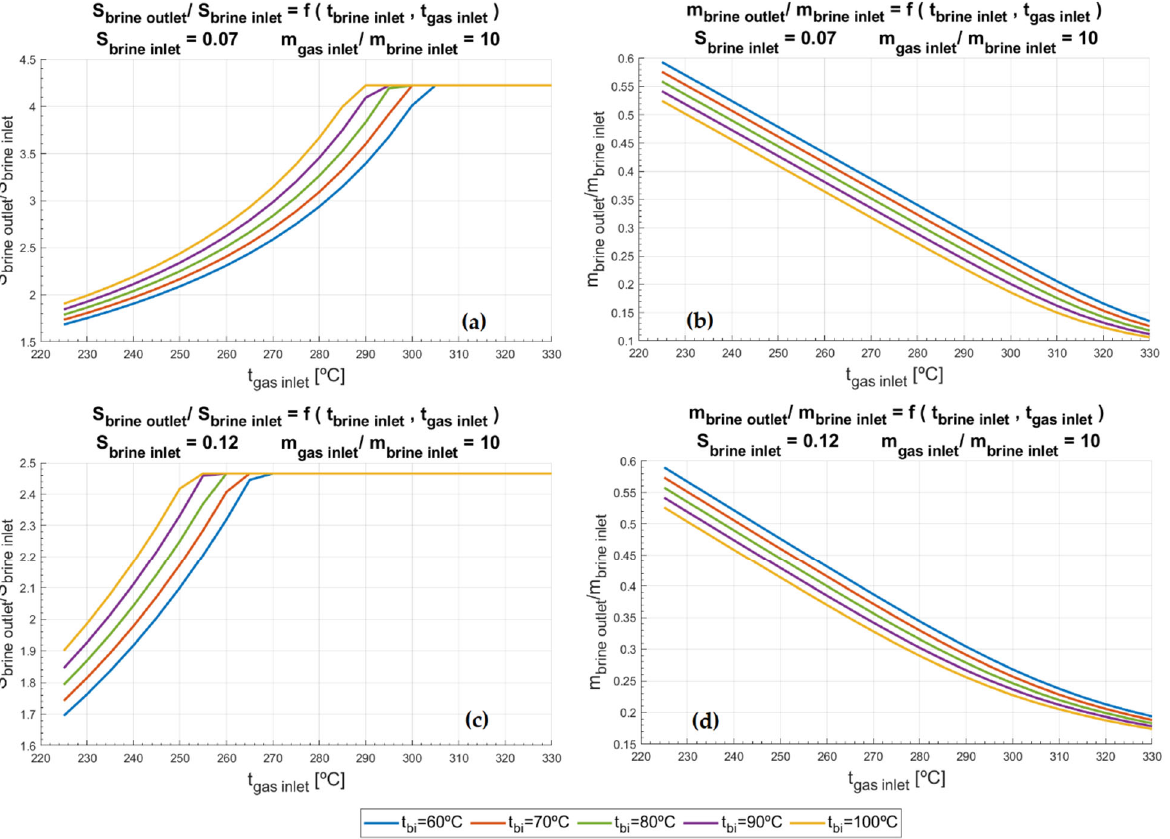
Figure 6. ( a ) Ratio between outlet and inlet brine salinities as a function of temperatures of inlet brine and inlet exhaust gases from the turbine in evaporation chamber, for S bi = 0.07 kg/kg and m g /m b = 10; ( b ) Ratio between outlet and inlet brine mass flow rates as a function of temperatures of inlet brine and inlet exhaust gases from the turbine in evaporation chamber, for S bi = 0.07 kg/kg and m g /m b = 10; ( c ) Ratio between outlet and inlet brine salinities as a function of temperatures of inlet brine and inlet exhaust gases from the turbine in evaporation chamber, for S bi = 0.12 kg/kg and m g /m b = 10; ( d ) Ratio between outlet and inlet brine mass flow rates as a function of temperatures of inlet brine and inlet exhaust gases from the turbine in evaporation chamber, for S bi = 0.12 kg/kg and m g /m b = 10.